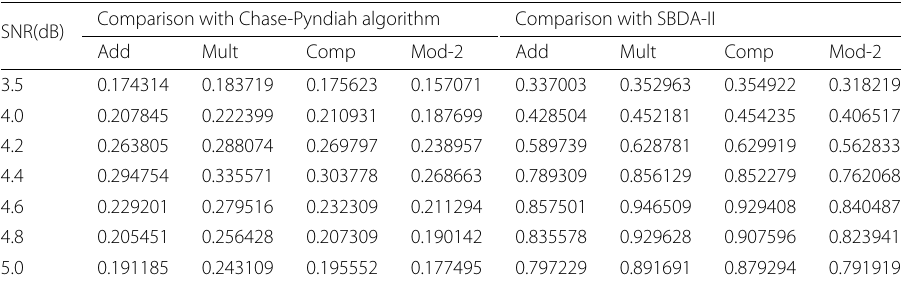
Table 9 The relative complexity result of ( 256, 247, 4 ) 2 TPC for four arithmetic operators on the proposed decoding algorithm when each complexity of Chase-Pyndiah algorithm and SBDA-II are set to 1 (Add: addition, Mult: multiplication, Comp: comparison, Mod-2: